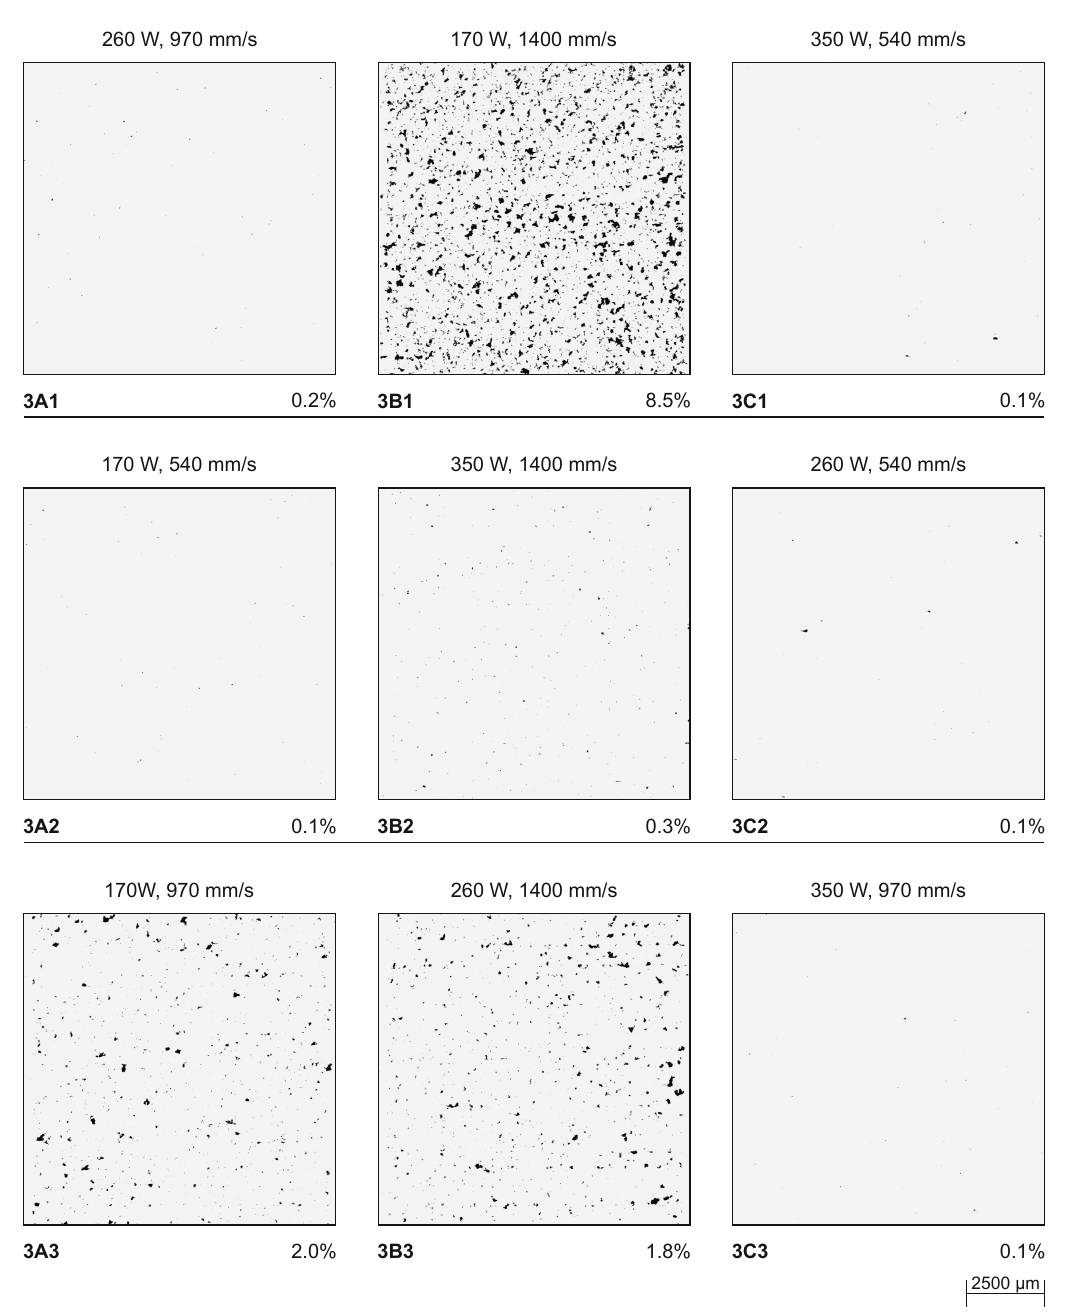
Figure A3. Display of porosity for the third replication of